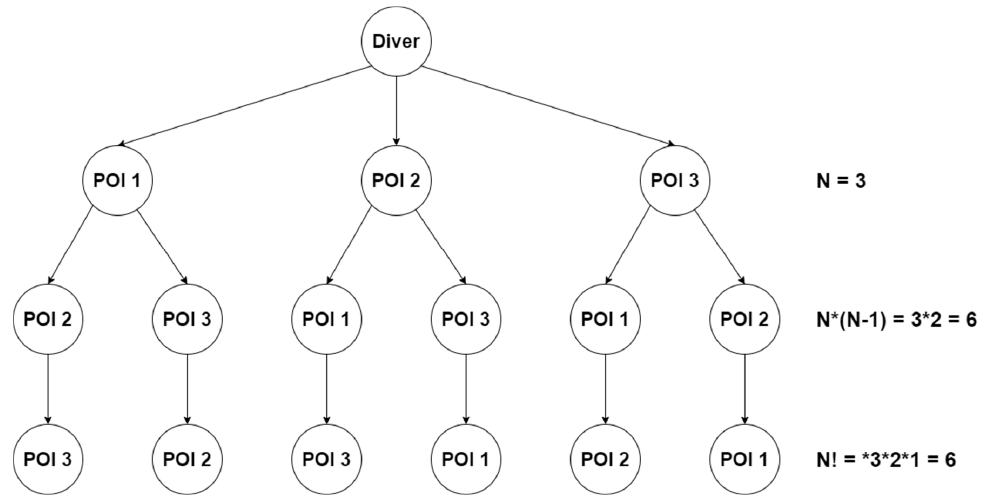
Figure 3. The search tree in the sample case of three points of interest (POIs).